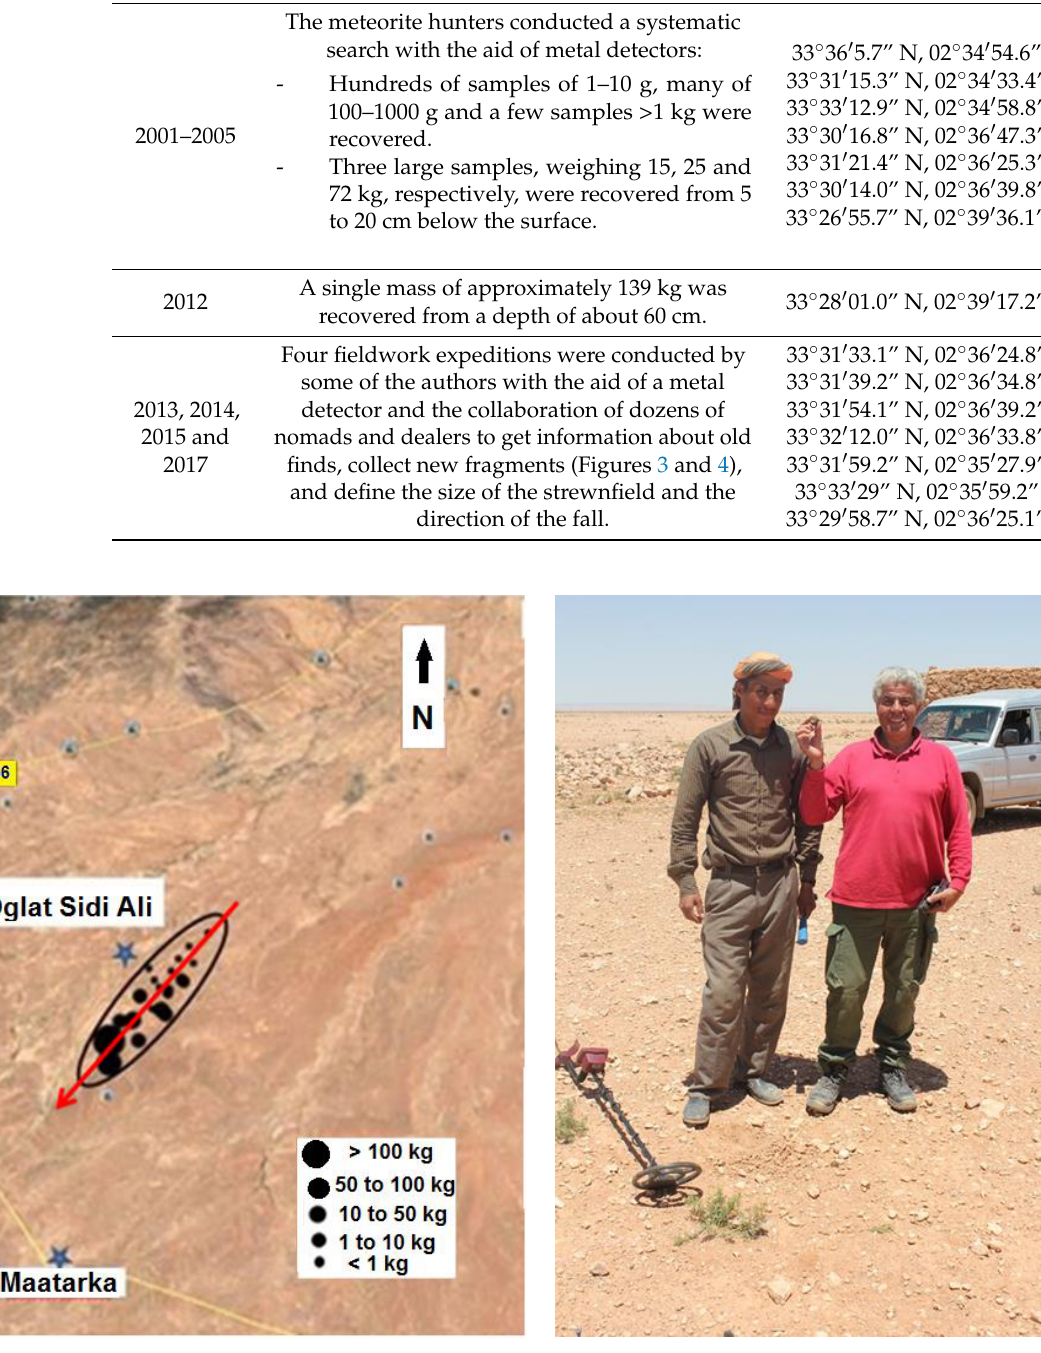
Figure 3. Strewnfield of the Oglat Sidi Ali meteorite (left). Prof. Nachit with a nomad of the region with a meteorite fragment find (right).